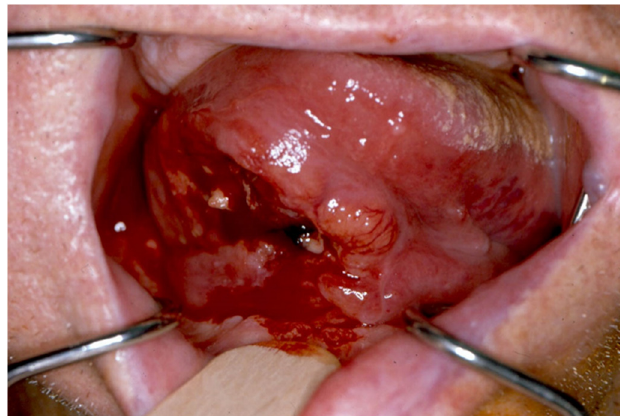
Figure 1. Squamous cell carcinoma (SCCA) involving the right tongue and the floor of the mouth. A homolateral selective cervical dissection with resection of the tumor of the tongue and floor of the mouth with free margins was performed. The defect to be reconstructed was 5.7 × 3.6 cm and a FAMM flap was designed for reconstruction (Figure 2).